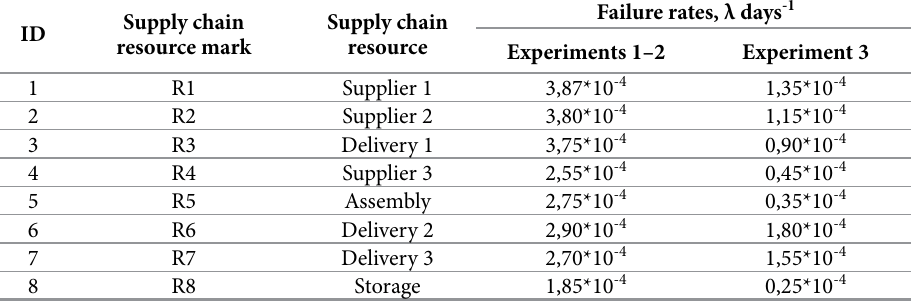
Table 3. Functioning characteristics of supply chain